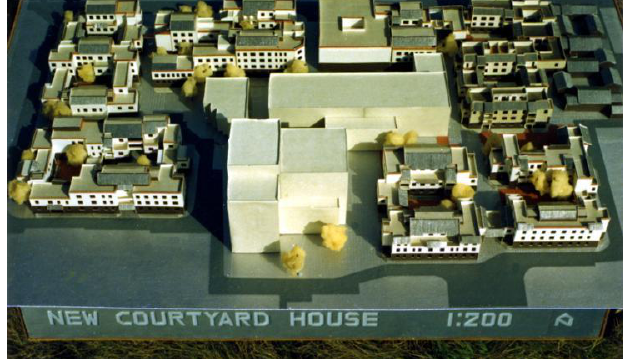
Figure 4. Model of Beijing Juer Hutong new courtyard